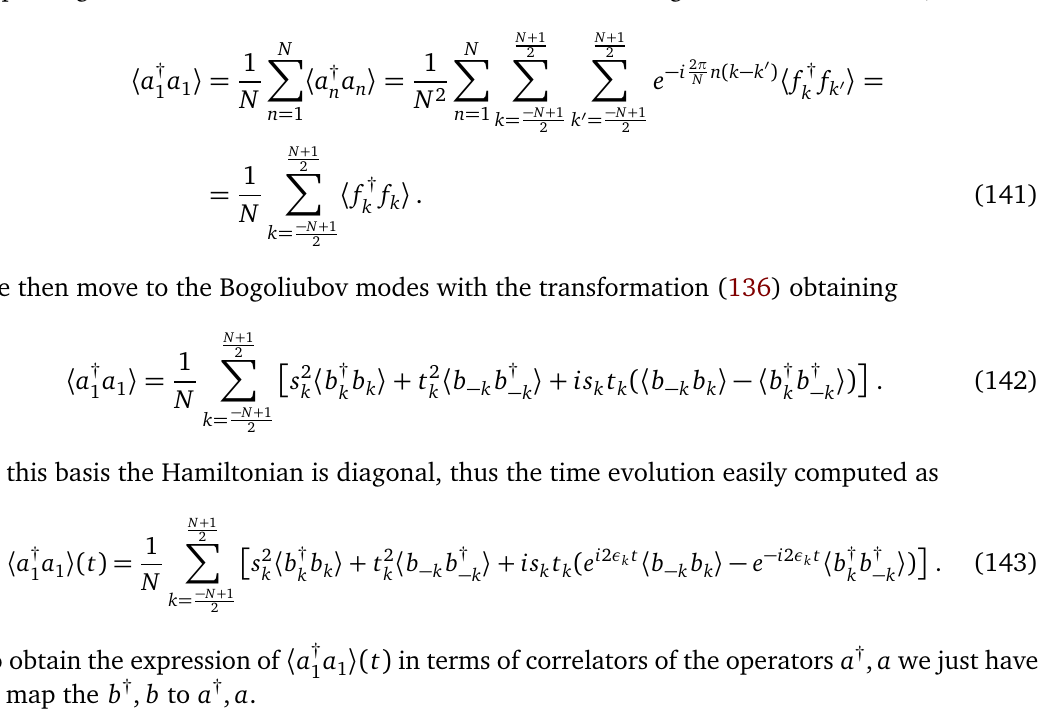
Figure 9: The ground states of Hamiltonians (122) for g tially to the same value. The ground state of the antiperiodic and of the periodic transverse field Ising model is degenerate in the thermodynamic